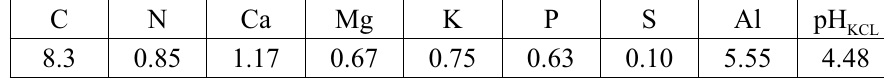
Mean content of minerals in the soil 20 cm deep (g x kg 1 ) and